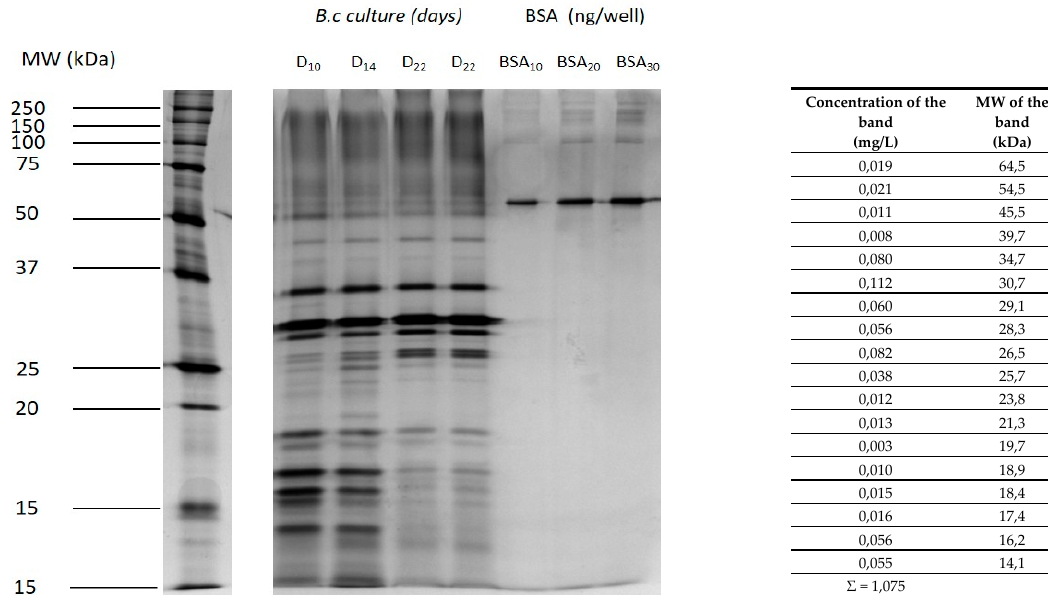
Figure 1. One-dimensional sodium dodecyl sulfate-polyacrylamide gel electrophoresis (SDS-PAGE) analysis of the secreted proteins by Botrytis cinerea 630 in a synthetic medium. D 10 , D 14 , D 22 : Days of the culture. The Botrytis cinerea culture was filtered, dialyzed (100×), and then concentrated (15×) using Amicon Ultra-4 unit. A total of 15 µL (+ 5 µL Laemmli buffer) of the ultra-concentrate were loaded/well. The bovine serum albumin (BSA) was loaded at 10, 20, and 30 ng/well. Botrytis cinerea protein concentrations for D 22 were calculated by comparison with the BSA calibration curve.